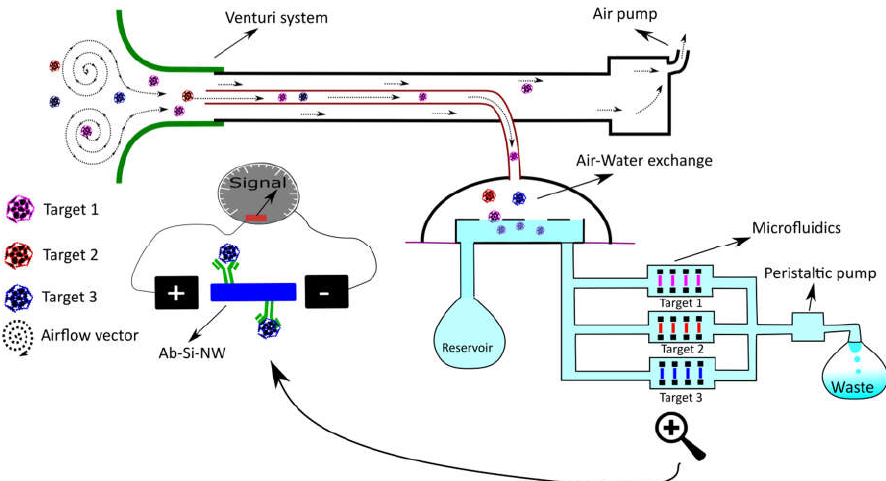
Figure 2. Schematic representation of a multiplex system for pathogen detection in air. The system depicted here follows the same principle as suggested in [100]. To this principle we added a presentation of enhanced aerodynamic reach as developed by [102] in combination with a simple microfluidic system to reach multiplex detection of several targets (as presented by pink, red and blue color